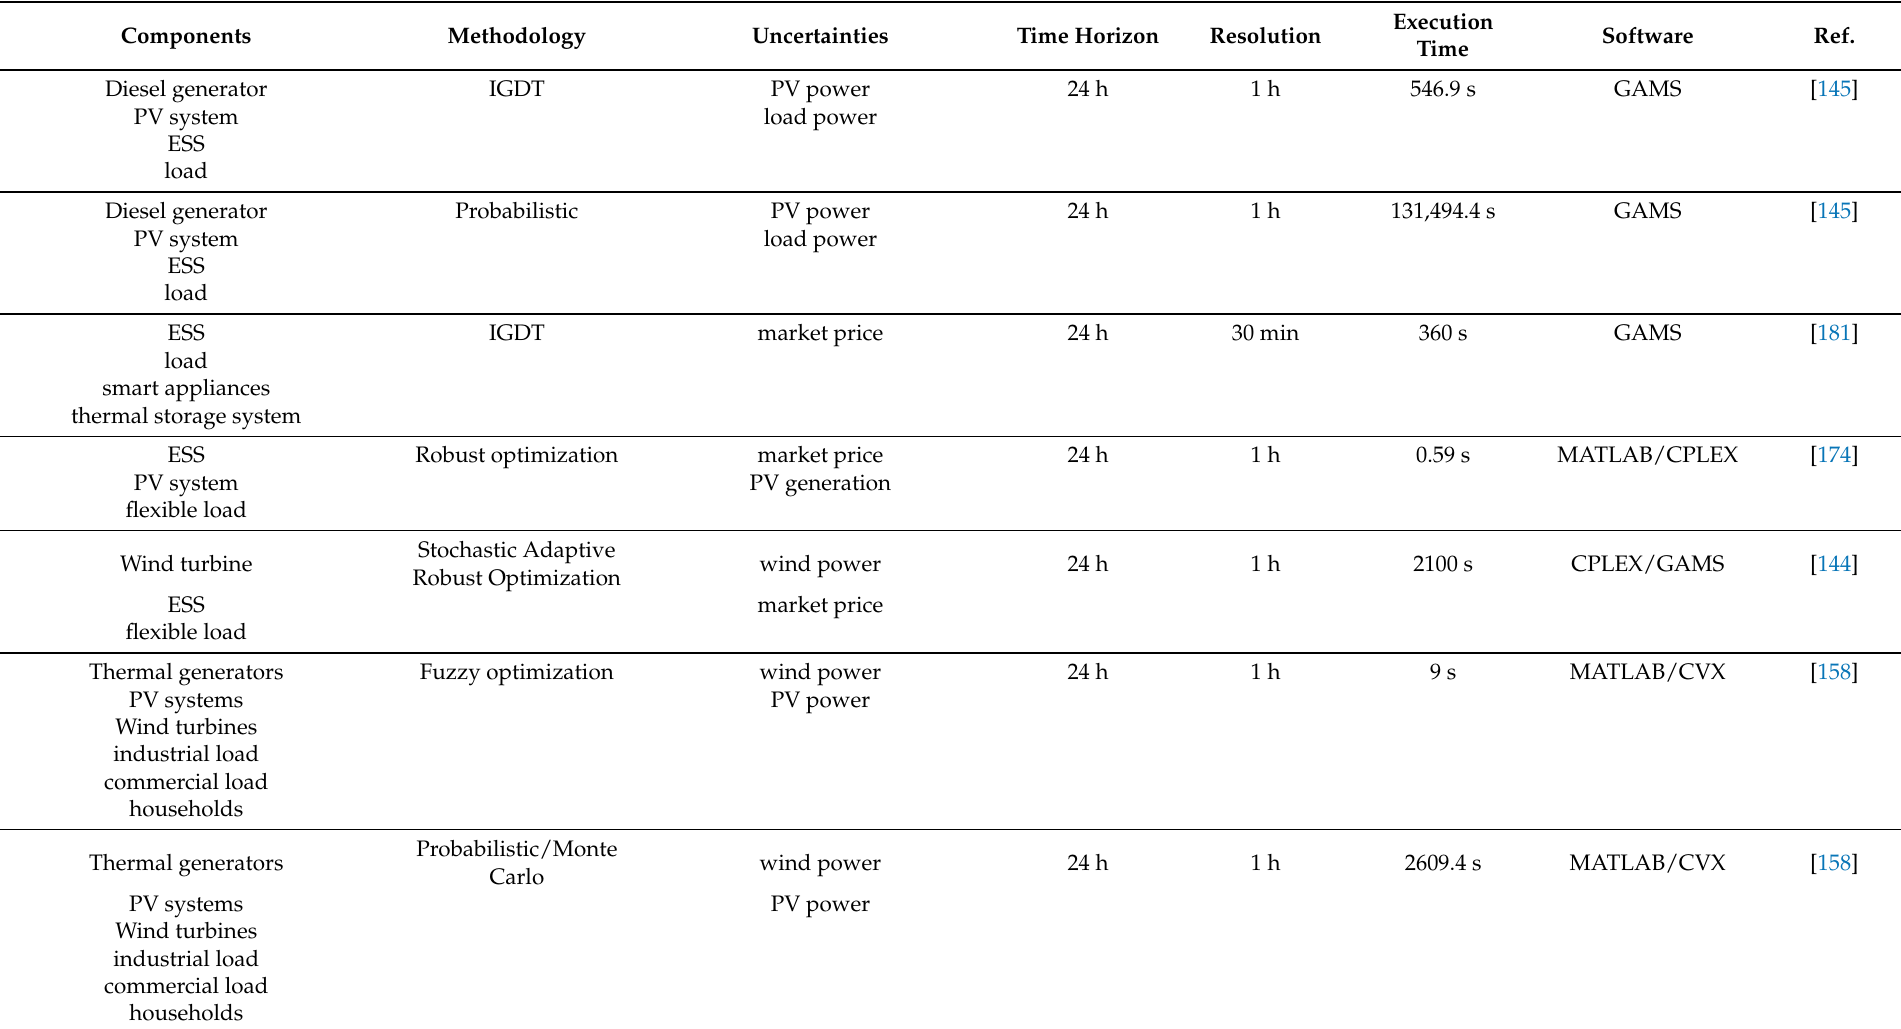
Table 11. Comparison of different optimization techniques regarding the computation